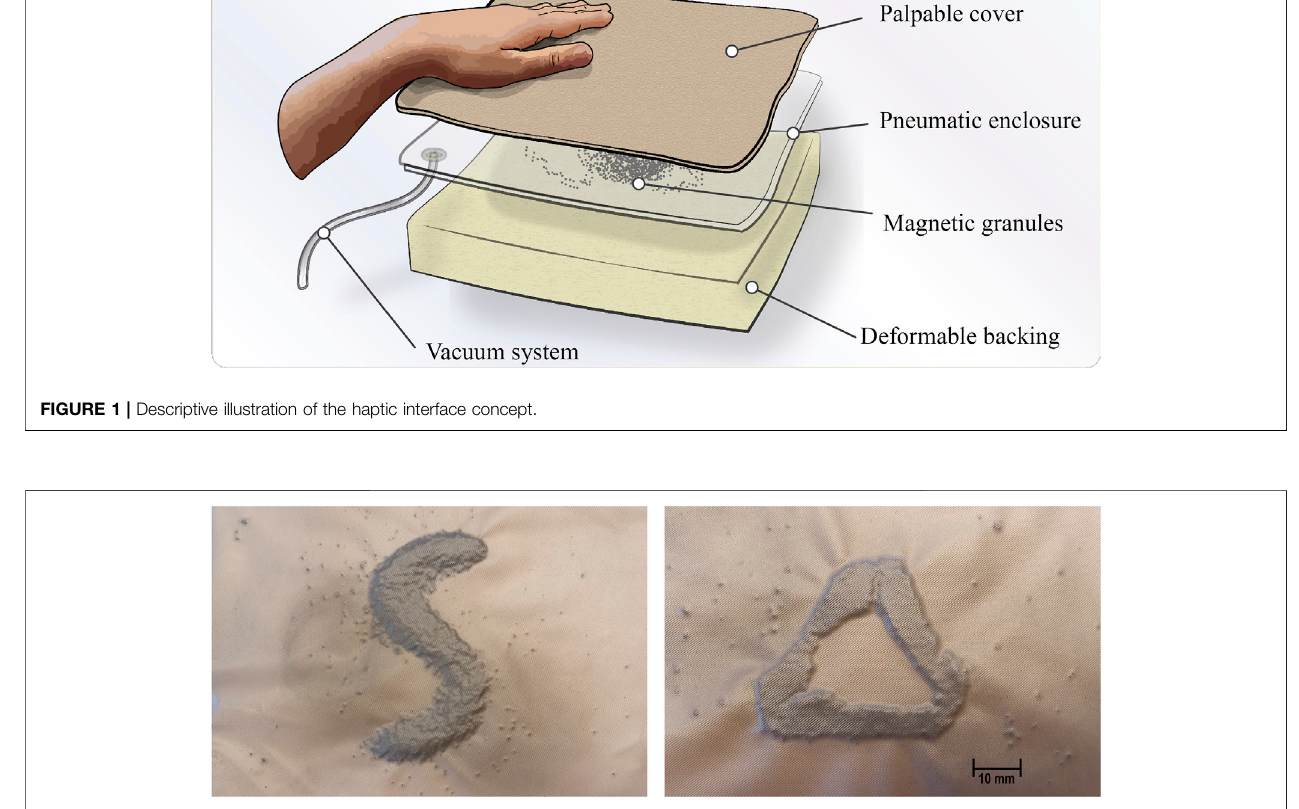
FIGURE 2 | Pictures of two arrangement